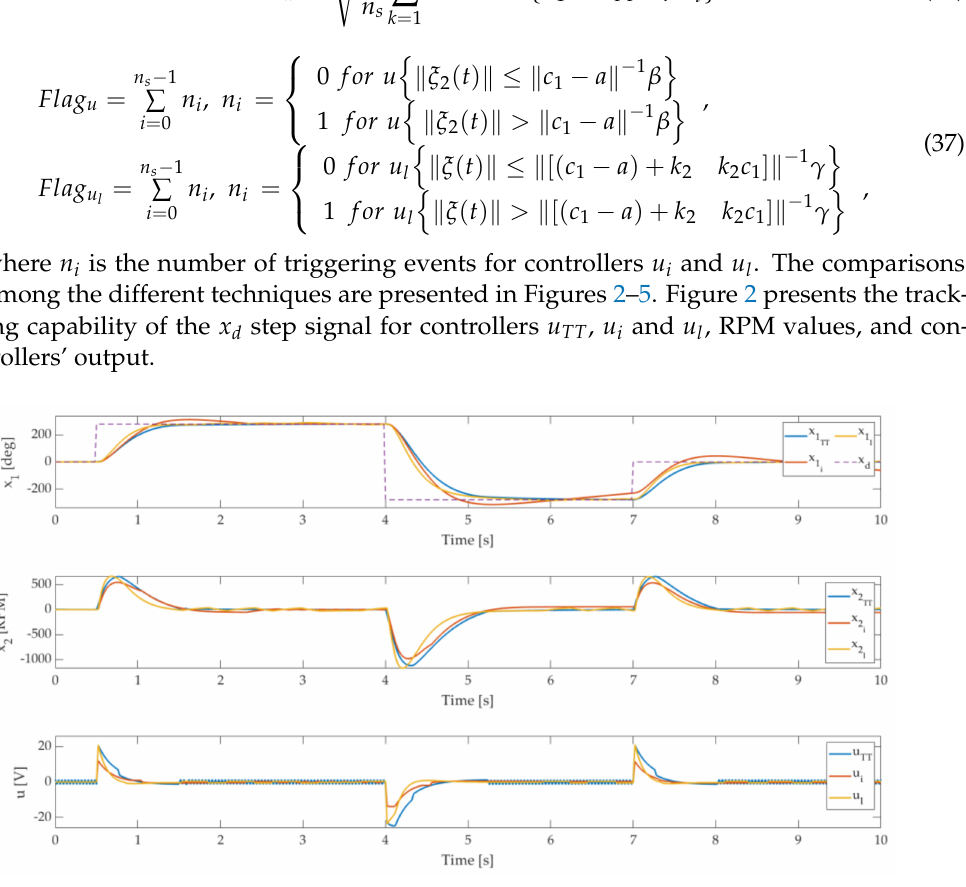
Figure 2. Tracking capability comparison of TT and ET techniques, with variables x 1 x 2 , controllers’ output u TT , u and u l .